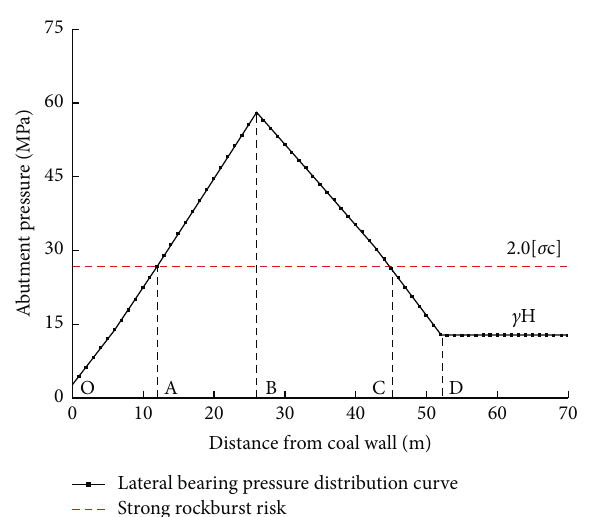
Figure 5: Lateral bearing pressure curve in goaf of working face (4-